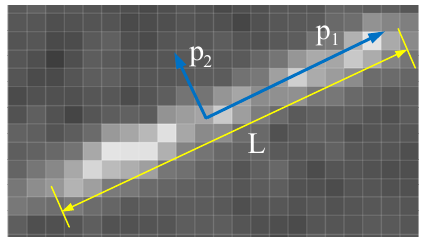
Figure 2. Shape features of a star point.